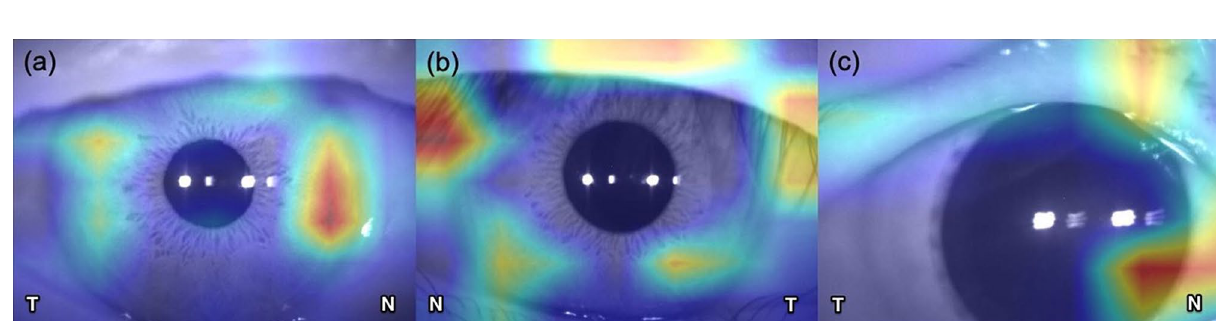
Figure 4. Class activation map was able to identify characteristic areas (nasal limbal area and iris area) in anterior segment photographs, which are presented as a heat map. ( N nasal, T